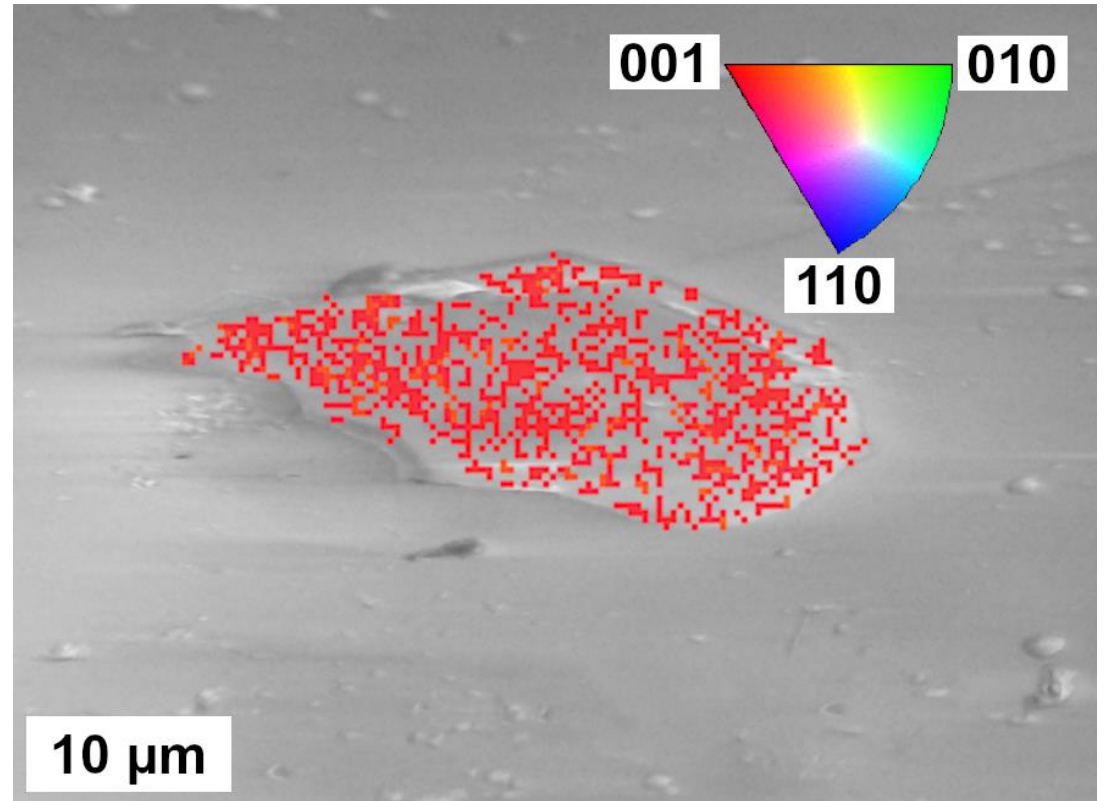
Figure 9. EBSD map of apatite included within betafite (polished section) superimposed over a CL image of the analyzed grain. The distribution of orientation solutions is highly consistent across all data points. No diffraction was observed from the surrounding betafite during mapping. Surface imaged using a 0.8° scan rotation, 70° sample tilt, accelerating voltage of 10.0 KeV, 10.0 mm working distance, and a 120 μm aperture. EBSD mapping utilized a μm 0.5 step size.